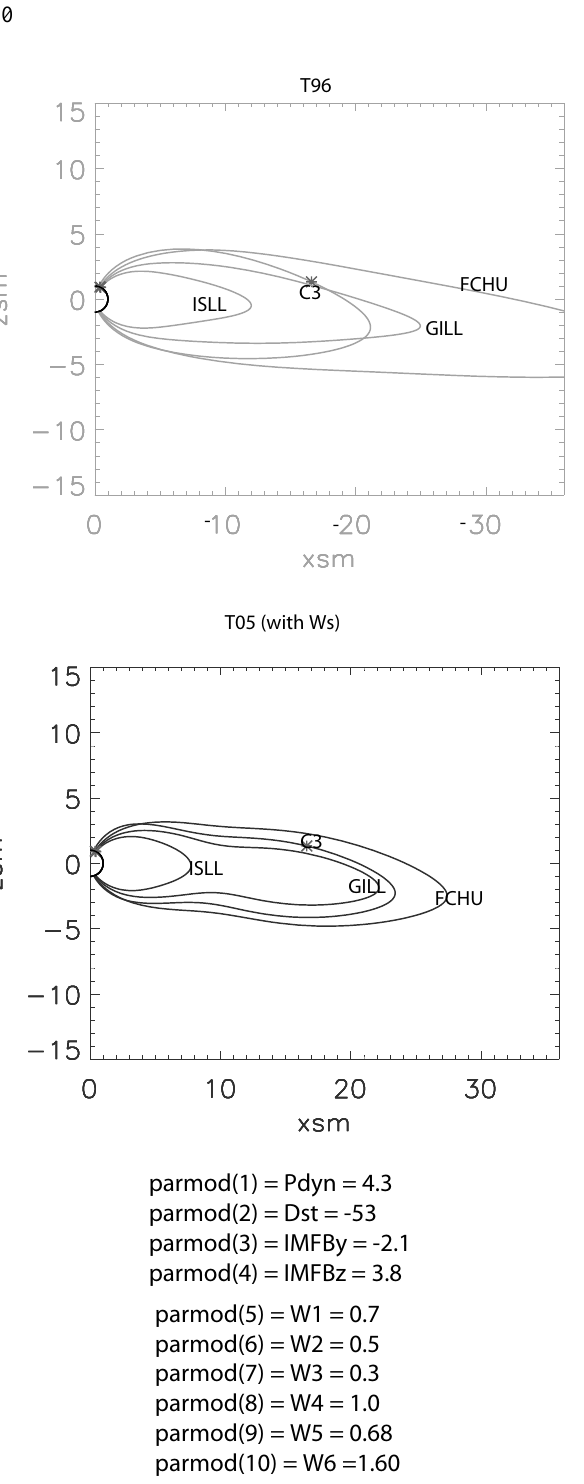
Fig. 14. Modeled magnetic field lines in the x-y plane in SM coor- dinates with (a) from the T96 model and (b) from the T05 model. The magnetotail is rather stretched from both